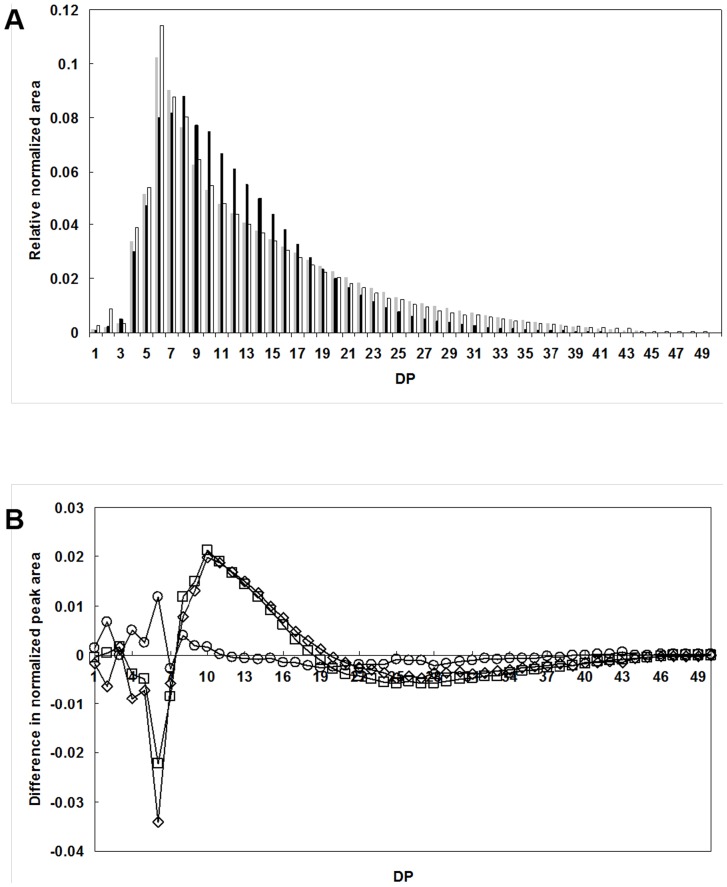
A. Branch chain-length distribution of glycogens from WT (), M1 (▪), and M2 (□). Glycogen samples were treated with a debranching enzyme, isoamylase, and the resulting debranched-samples were separated on an HPAEC system. The peak area was calculated and normalized from the chain-profile chromatogram. B. The comparison of difference in the normalized peak area calculated from M1-WT (□), M2-WT (○), or M1-M2 (⋄).